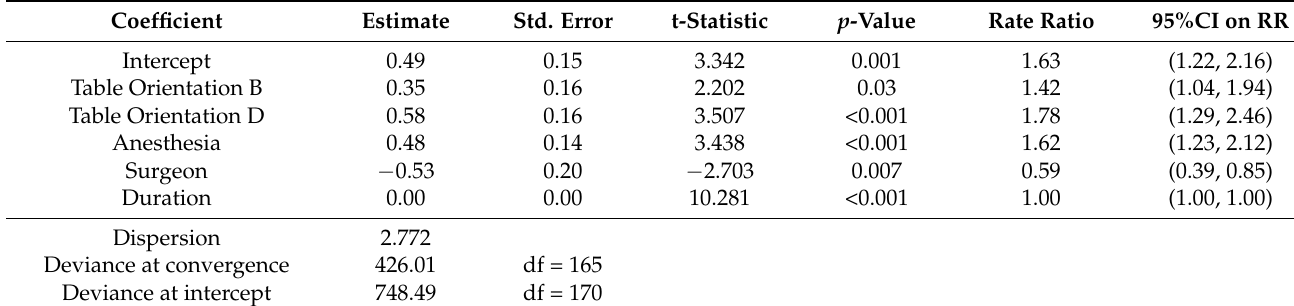
Table 6. Quasi-Poisson regression model predicting the number of major flow disruptions during the intraoperative phase. Coefficient